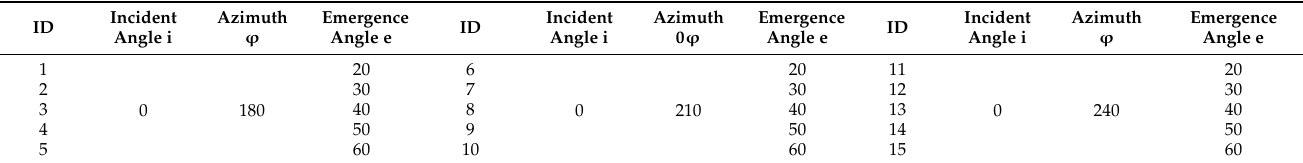
Table 1. Configuration table of the measured angle for the multi-angle spectral